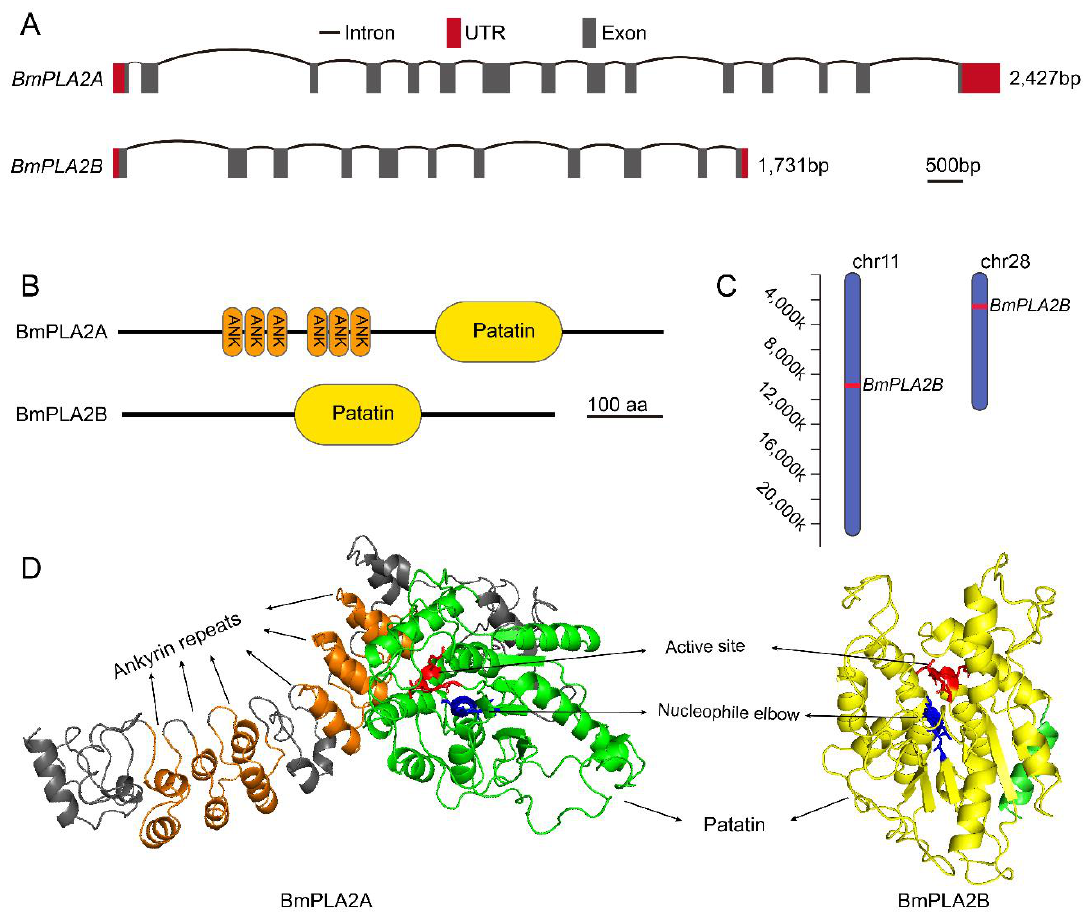
Figure 1. Two calcium-independent phospholipase A2 (iPLA2) genes from Bombyx mori . ( A ) The gene structure of BmiPLA2A and BmiPLA2B in silkworm. Exons and introns are represented by black line segments and grey boxes, and 5′ untranslated regions (UTR, left) and 3′ UTR (right) were shown in red boxes. The black scale bar indicates 500 bp. ( B ) Conserved domains of BmiPLA2A and BmiPLA2B predicted by SMART program. ( C ) The chromosome location of BmiPLA2A and BmiPLA2B . ( D ) Three-dimensional structure prediction of BmiPLA2A and BmiPLA2B. The six ankyrin repeats of BmiPLA2A are colored with orange. The conserved patatin domains of BmiPLA2A and BmiPLA2B were colored with green and yellow, respectively. The active sites and nucleophile elbows were shown in red and blue in the sticks, respectively.